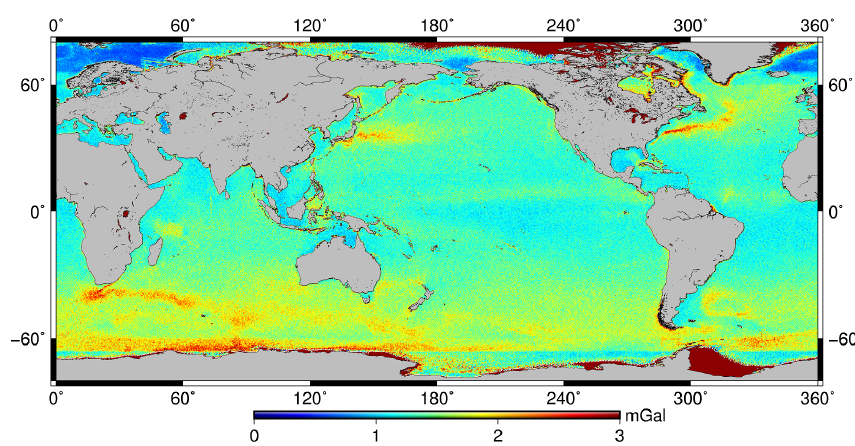
Figure 11. Map of gravity anomaly error based on deviations of along-track geoid gradients from all altimeters.